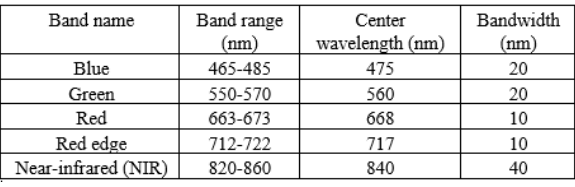
Spectral characteristics of the five MicaSense